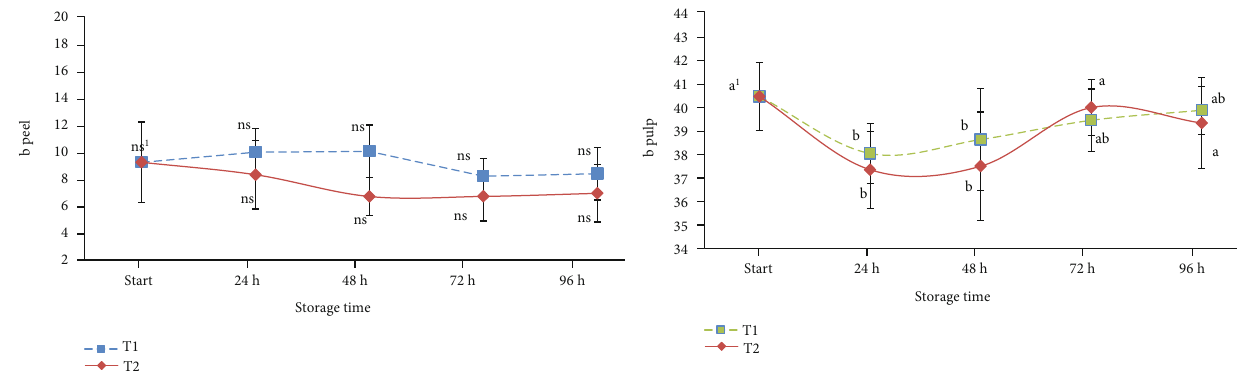
Figure 4: Evolution of the yellowness (b) colour parameter of stored cv. Hass (peel and pulp). Values followed by di ff erent letters are signi fi cantly di ff erent at P ≤ 0 : 05 (Tukey ’ s post hoc Table 3: Evolution of texture parameters of avocado cv. Hass during storage. Samples